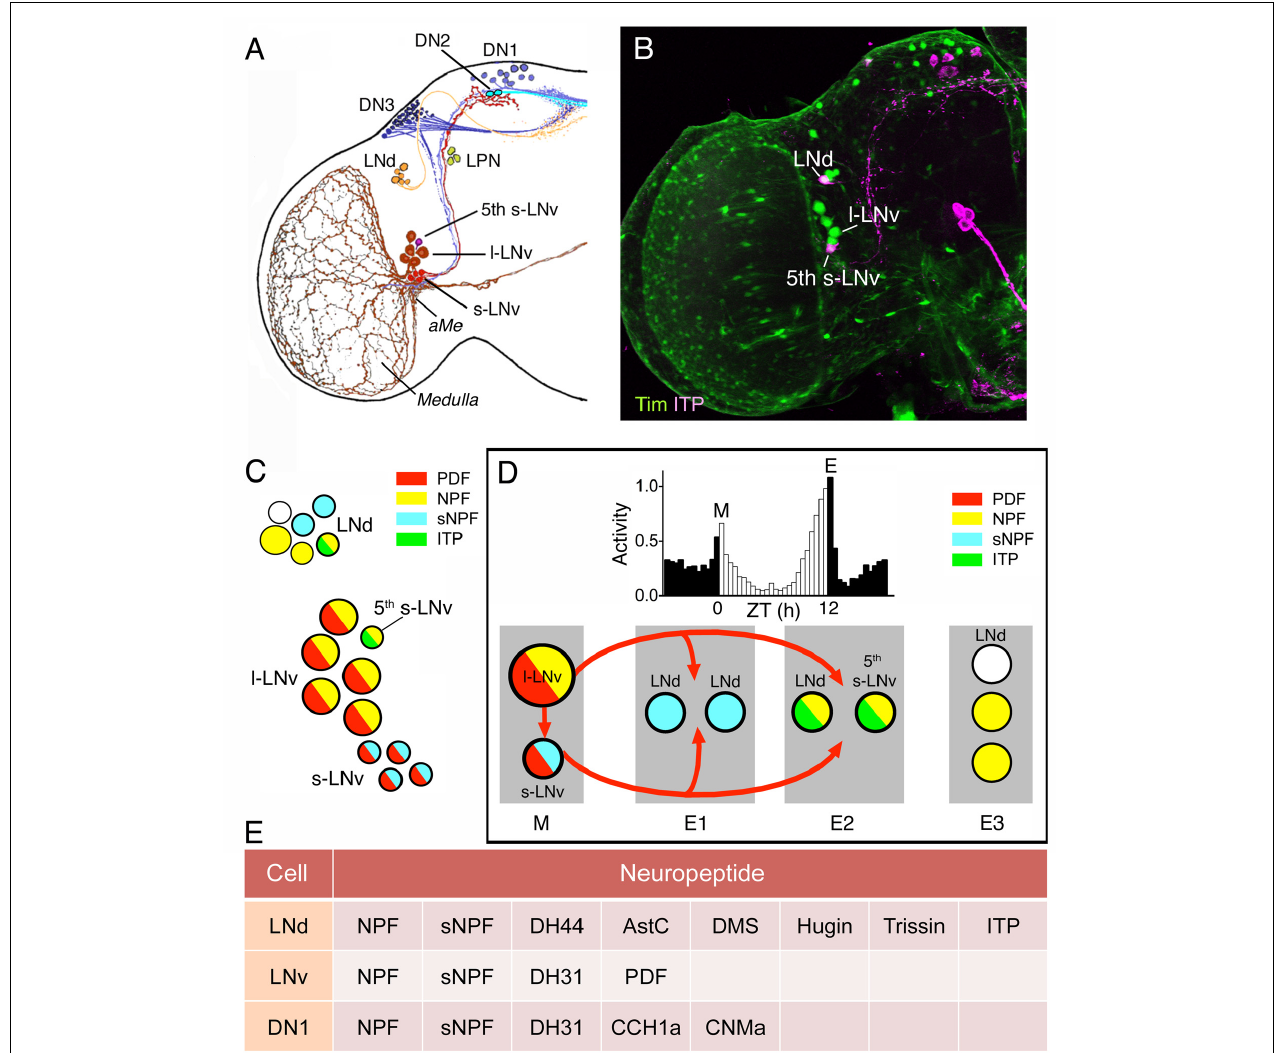
FIGURE 5 | Several neuropeptides are colocalized in different types of clock neurons in Drosophila . (A) The different types of clock neurons in one brain hemisphere. There are lateral ventral neurons (s-LNv and l-LNv), lateral dorsal neurons (LNd), dorsal neurons (DN1–DN3), and a set of lateral posterior neurons (LPN). aMe, accessory medulla. This panel is originally from Helfrich-Förster et al. (2007), but slightly modified in Johard et al. (2009). (B) Expression of Tim-Gal4-driven GFP (green) and immunolabeling for ion transport peptide (ITP; magenta). From Johard et al. (2009). (C) Neuropeptides in LNd and LNv neurons are colocalized in different patterns. The figure is compiled from data in Johard et al. (2009) and Schlichting et al. (2016). Note that the s-LNvs also produce the amino acid transmitter glycine (Frenkel et al., 2017) and l- LNvs the cytokine Upd1 (Beshel et al., 2017). (D) The clock output generates daily activity with peaks in the morning (M) and evening (E) and low activity at night and mid-day. This activity is generated by clock neurons that act as morning (M) and evening (E1–E3) oscillators. These express different combinations of neuropeptides and some interactions between LNvs and other neurons are known to be by means of pigment-dispersing factor (PDF) shown in red arrows. The roles of other peptides are less known so far (but, see Figure 6 ). This figure is compiled in part from data in (Schlichting et al., 2016). (E) This table shows additional neuropeptides in clock neurons indicated by singe cell transcriptomics. Note that the cell types listed were assayed as groups and there is no information on peptides in subtypes of neurons in these groups. Thus it is not known to what extent the neuropeptide transcripts are coexpressed in specific neurons; this is especially prominent for the relatively large group of DN1 neurons, which may be heterogeneous. Data mined from Abruzzi et al. (2017).